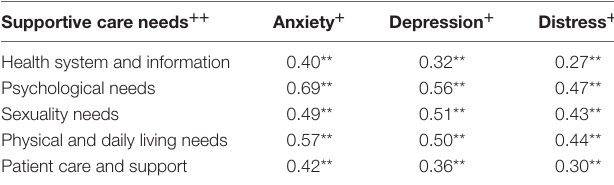
TABLE 4 | Association of supportive care needs in male partners and mental burden in male partners (self-assessment) of female patients with breast cancer (Pearson’s